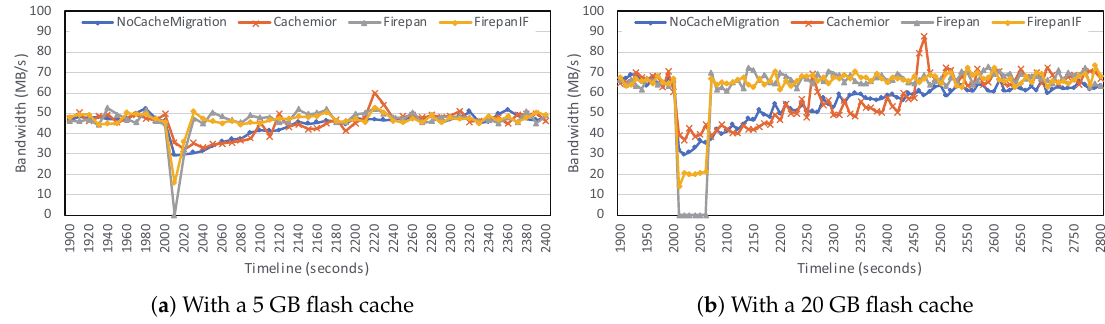
Figure 10. Bandwidths before and after VM migration with various flash cache